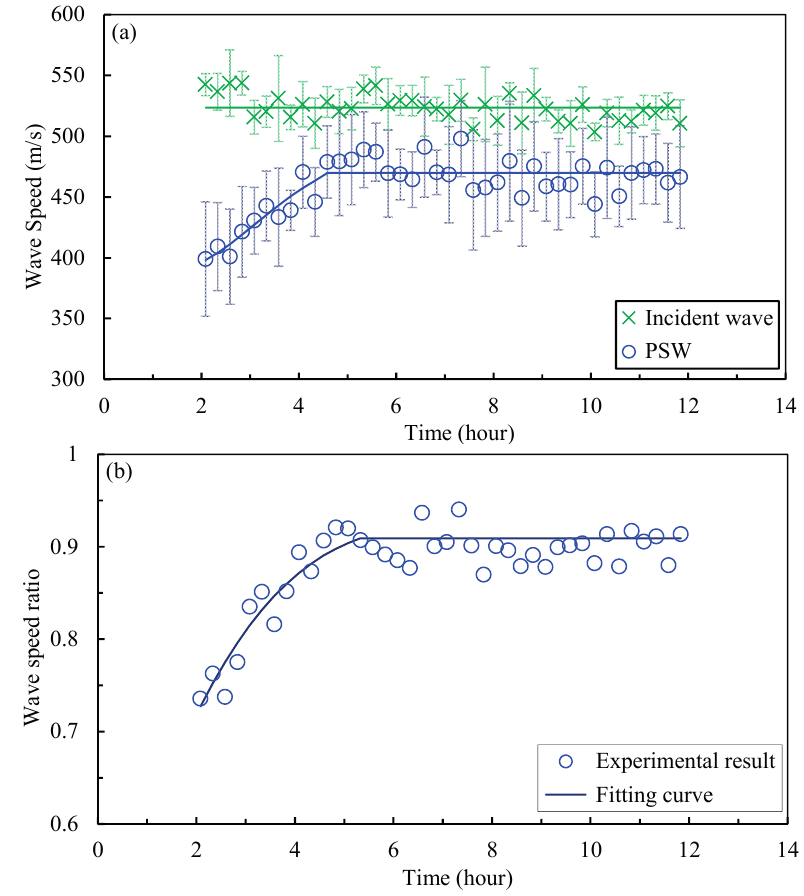
Figure 7. ( a ) Experimental results of wave speed of incident HNSW and PSW; ( b ) The ratio of the wave speed of PSWto that of incident